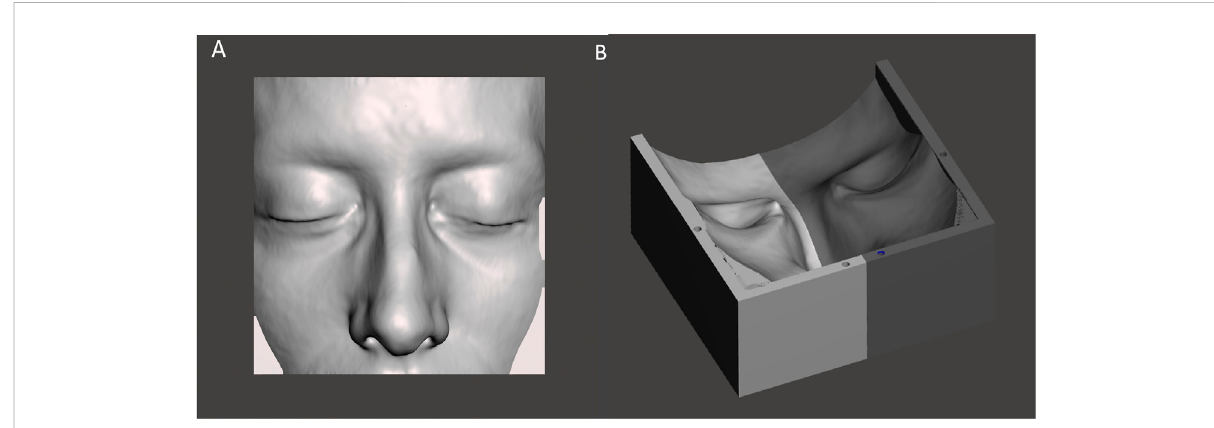
FIGURE 3 The STL fi le of the patient-speci fi c portion of skin (A) used to create the virtual model of the facial mold (B)